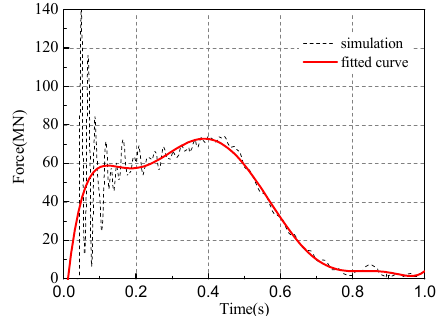
Figure 9. The collision force–time curve.